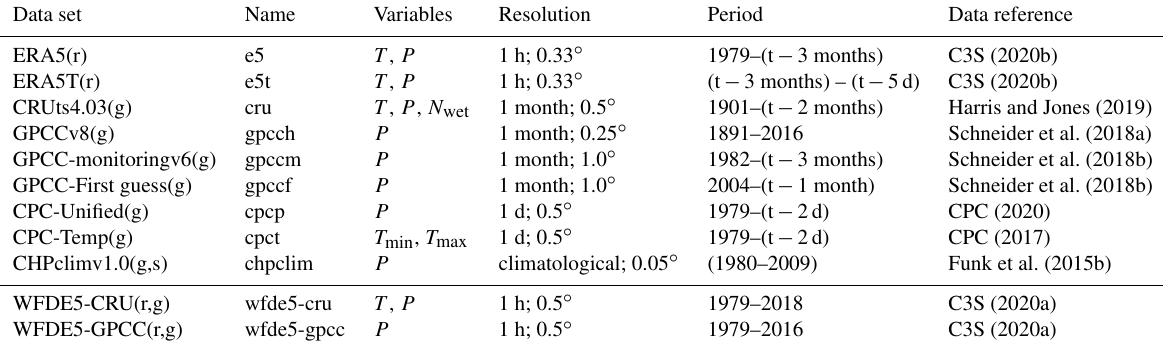
Table 1. Table of model and data sources used in the production of HydroGFD3 as well as the WFDE5 data set used for comparison. Note the lower-case abbreviations used in the main text and in figures, which follow the internal notation used in the data set production. N wet is a measure of the number of wet days in a month. The data set type is marked in parentheses in the leftmost column; r: model reanalysis; g: gauge-based; s: satellite-based. Today’s date is marked by “t” in the “Period”